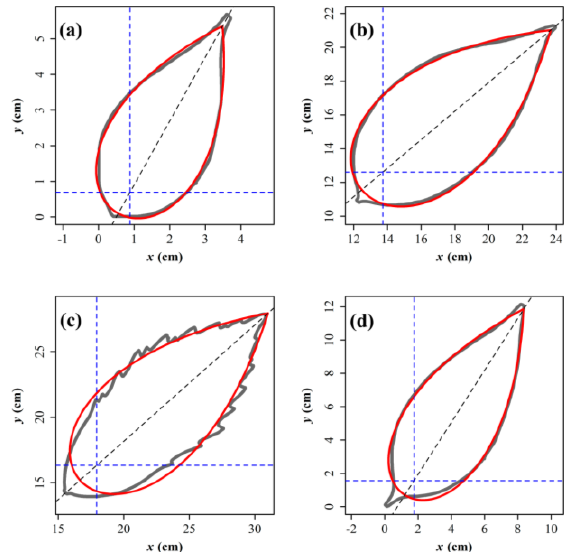
Figure 4. Fitted results using the SGE for four tree species. Panels ( a – d ) represent P. tobira , C. praecox , A. japonica var. variegata and P. sheareri , respectively. For every panel, the gray curve represents the scanned (observed) leaf edge, and the red curve represents the leaf edge predicted by the SGE. The leaves correspond to those in Figure 2.